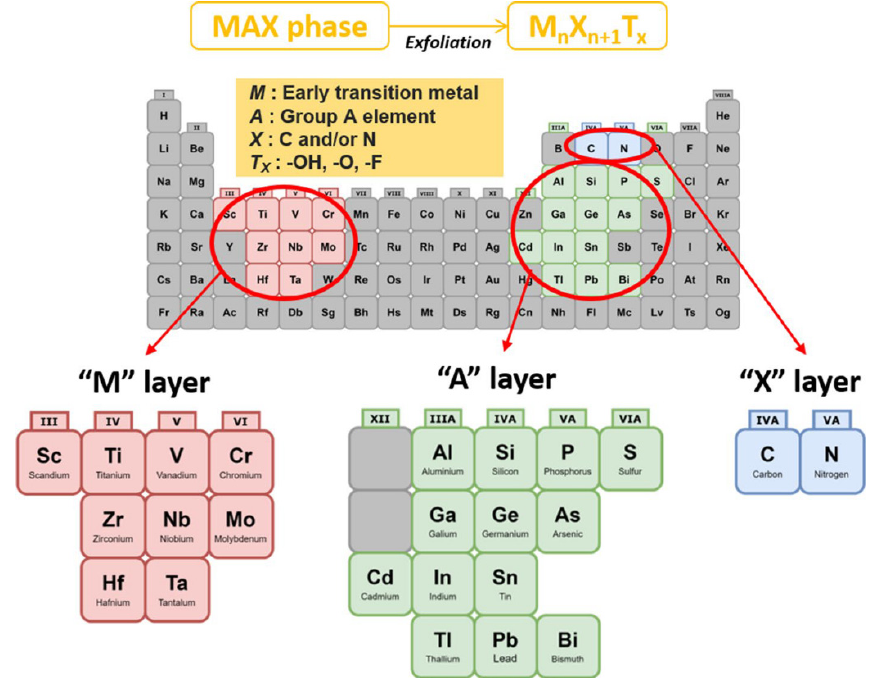
Figure 3. Periodic table of the elements that make up the ‘MAX’ phases as well as SMQDs: M: metals with early transition, I: ‘Group A’ element, X: C as well as Tx, and N: ‘surface function group’. (Reprinted with permission [81]. Copyright © 2021, The Author(s).)